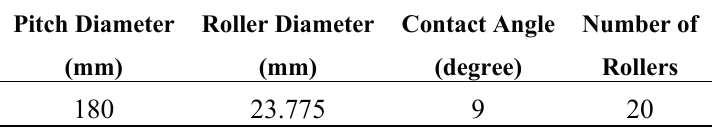
Table 1. Geometric parameters of the roller bearing.